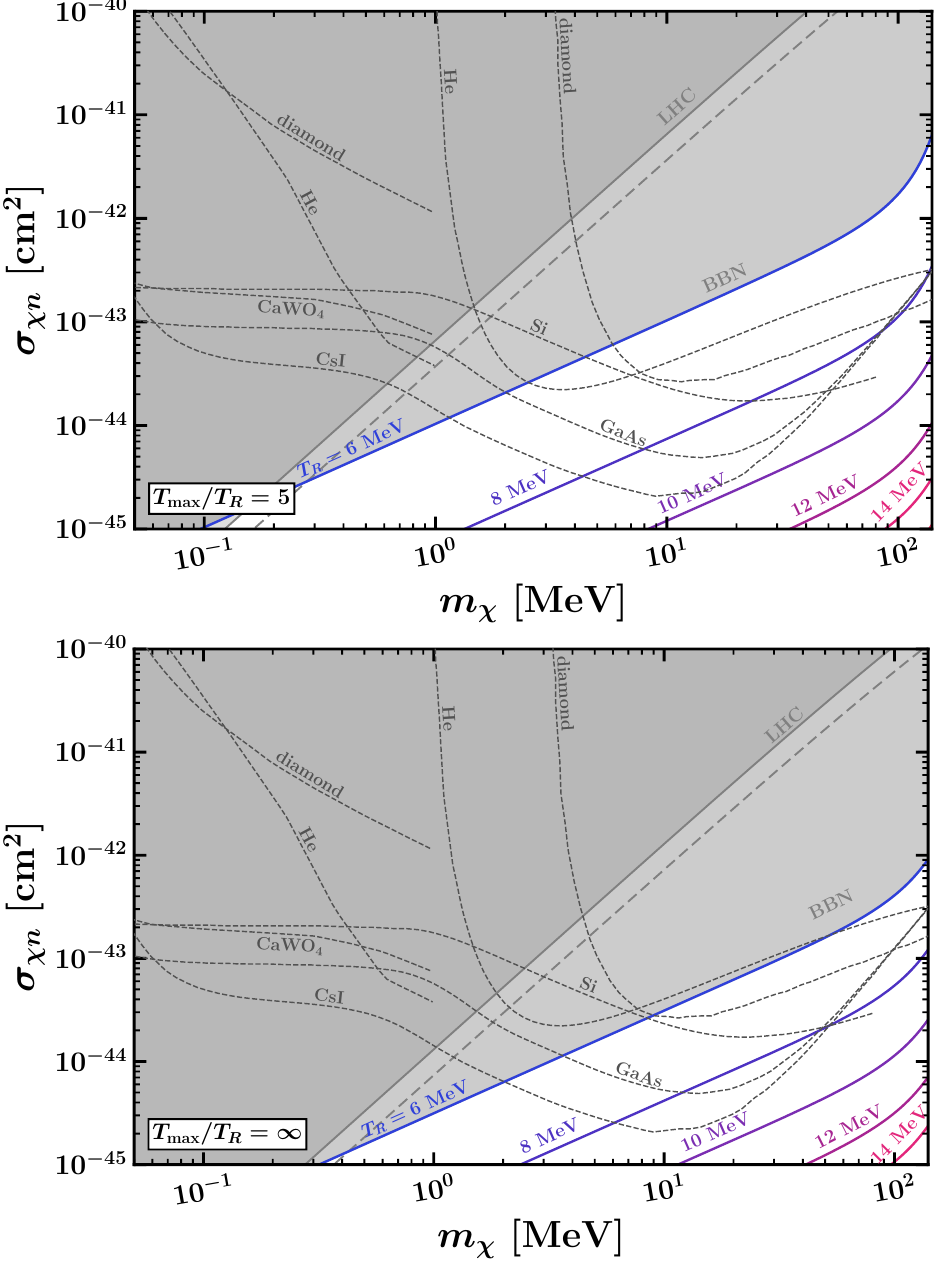
Figure 6 . The same as figure 3, but with T max /T R = 5 (top panel) or T max /T R = ∞ (bottom panel) instead of T max /T R ' 1